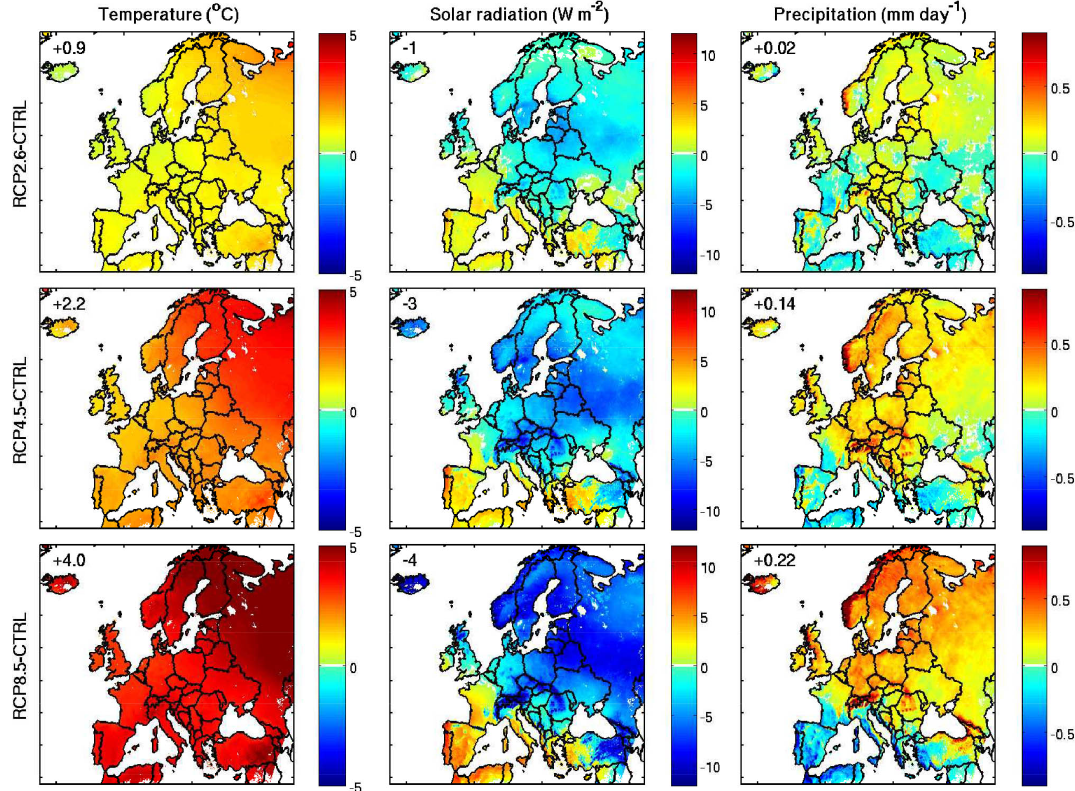
Figure 8. Absolute difference between the projected future and control simulations for temperature, surface shortwave radiation, and pre- cipitation averaged over 2070–2099 following different RCP scenarios. The mean values for each variable over the domain are given inside each